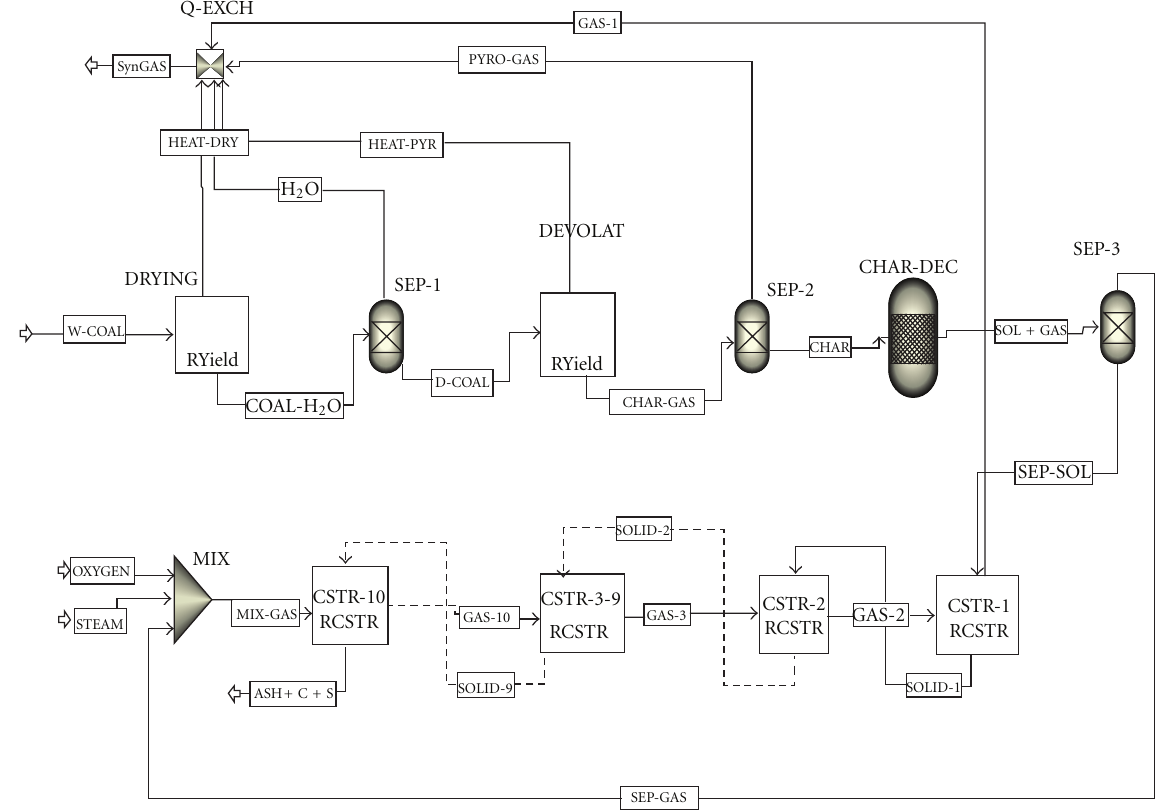
Figure 1: The process flow sheet (modified version of [12]) for the simulation